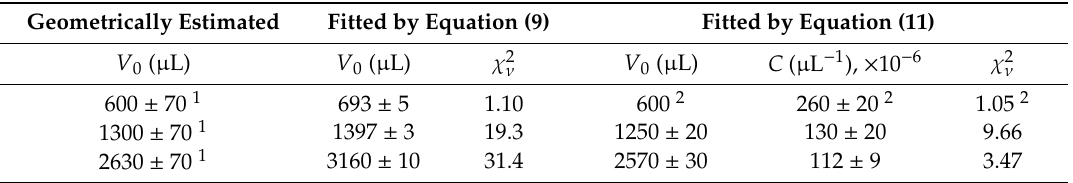
Table 1. Comparison of geometrically estimated initial volumes of the sensor and measured volumes calculated by Equations (9) and